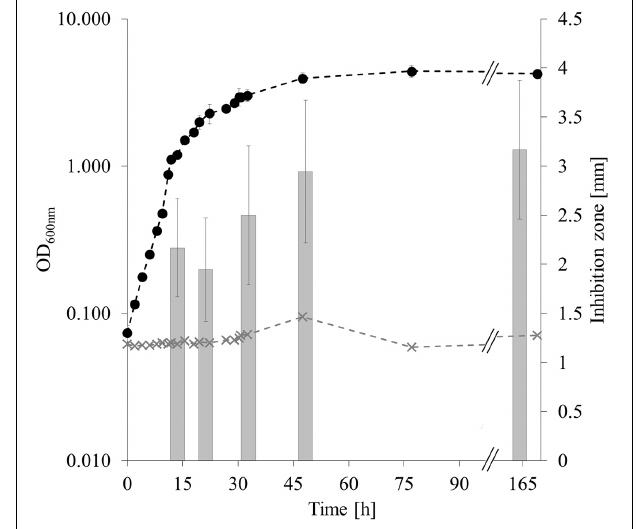
FIGURE 4 | Antagonistic activity of CP157 throughout different growth phases. Growth of CP157 (black dashed line) and medium control (gray dashed line) measured at OD 600 nm . Gray bars represent the antagonistic activity in mm at the sampling points. Samples were taken at OD 600 nm = 1, 2, 3, 4 ( t 1 - 4 ) and in the late stationary phase ( t 5 ). For means of visualization, the X-axis was shortened at //, without cutting off any measurements. Values are given as means ± standard deviation ( n OD = 3, n inhibition =